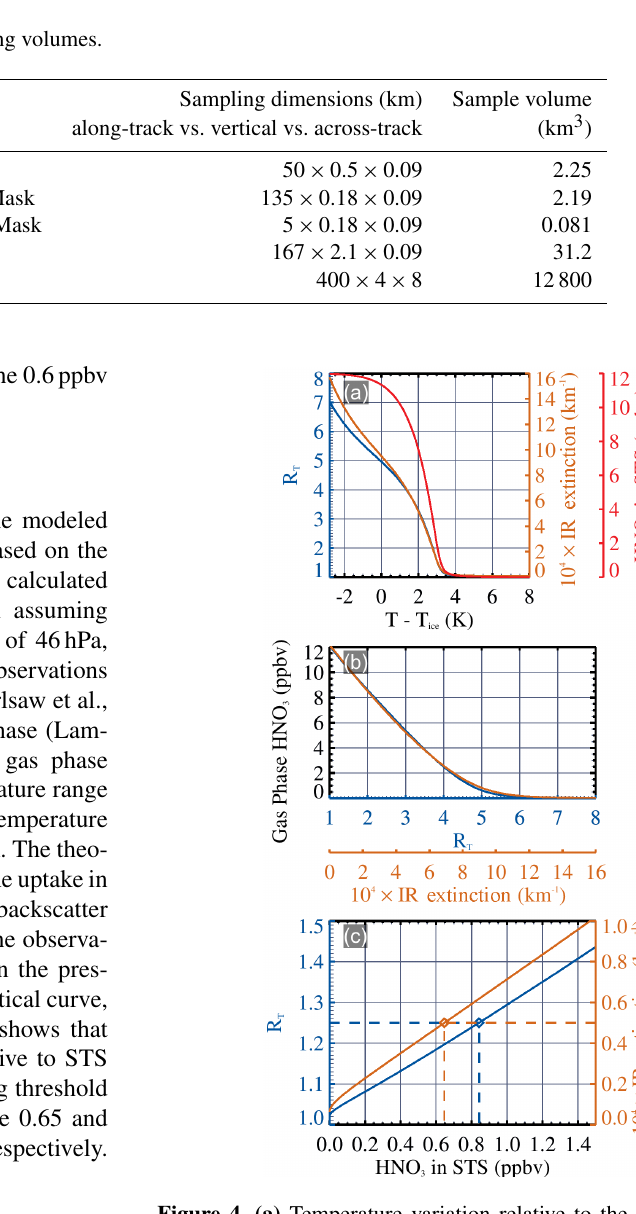
Figure 4. (a) Temperature variation relative to the frost point of the uptake of HNO 3 in STS (red), the calculated 532nm lidar total backscatter ratio, R T , (blue), and the 12µm infrared extinction (or- ange). (b) Gas-phase HNO 3 vs. 532nm total backscatter ratio (blue) and 12 µm infrared extinction (orange). (c) STS detection limits for lidar backscatter ratio (blue diamond) and infrared limb extinction (orange diamond) and correspondence to the uptake of HNO 3 in